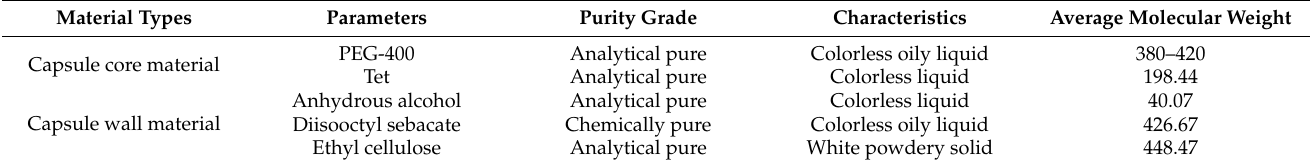
Table 1. Physical parameters of the capsule core and the capsule wall materials.